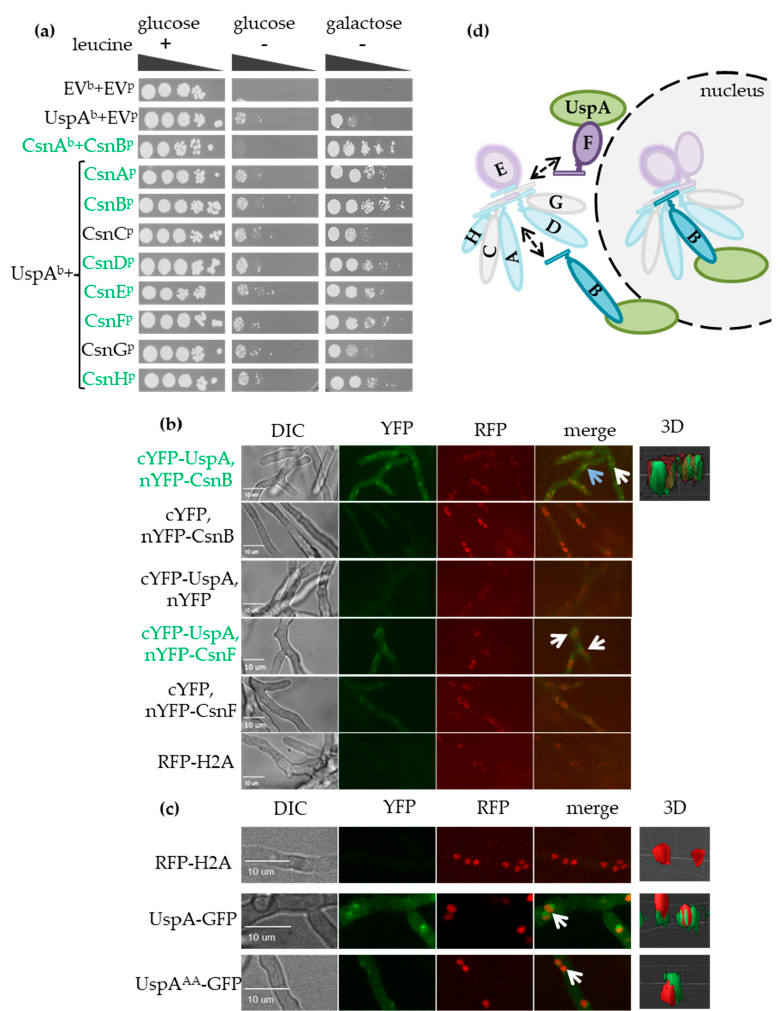
Figure 2. UspA-GFP is localized close to nuclei and interacts with COP9 signalosome subunits in vitro and in vivo . ( a ) Growth analysis of yeast cells, expressing UspA as bait ( b ) from the constitutive ADH1 promoter, and CSN subunits as prey ( p ), driven by the inducible GAL1 promoter on non-inducing (glucose) and inducing (galactose) medium. Yeast strains containing empty vectors (EV) served as control. Left panel: cells were spotted on selection medium containing glucose and leucine (positive growth control). The medium used for strain cultivation shown in the middle panel is not supplemented with leucine, which serves as negative growth control. The observed growth is due to auto-activation of the promoter due to the presence of uspA as bait. Yeast cells growing on the selective interaction medium (right panel) contain interacting bait and prey proteins. ( b ) BiFC assay was performed with CsnB and UspA, as well as with CsnF and UspA, that are fused to one half of YFP, respectively, during vegetative development in A. nidulans hyphae. Therefore, 2000 spores were inoculated in minimal medium and grown for 20 h in light at 37 °C. In the left panel, differential interference contrast (DIC) images of the hyphae are shown. All strains contain RFP tagged H2A to visualize nuclei (red). YFP fluorescent signal indicates the interaction of the two proteins in the nucleus (highlighted with blue arrow) or close to nuclei (highlighted with white arrows). Scale bars represent 10 µm. ( c ) Fluorescence microscopy was performed under the conditions described in (b) to investigate the subcellular localization of UspA-GFP and UspA AA -GFP fusion proteins in A. nidulans hyphae. ( d ) Model of the localization of UspA and interaction of the DUB with the COP9 signalosome. Subunits with interaction are shown in blue. UspA interacts with CsnB and CsnF in BiFC experiments and with CsnA, B, D, E, F, and H in a Y2H